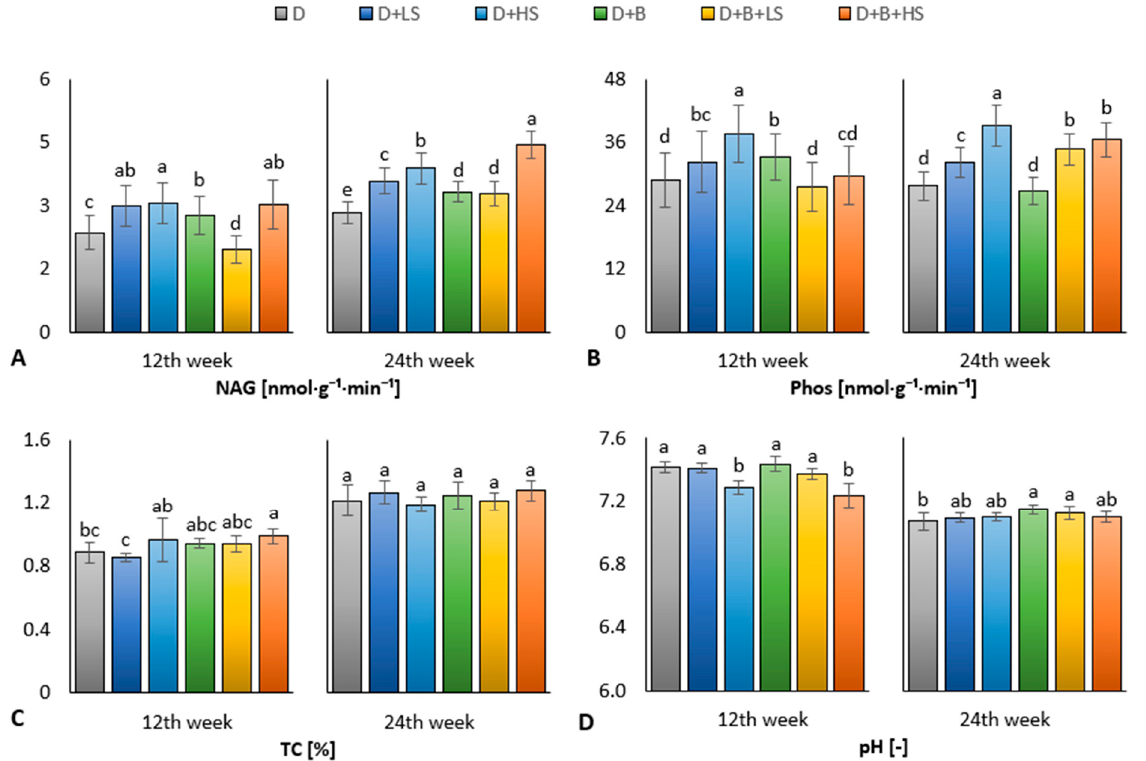
Figure 2. Soil activity of N-acetyl- β -D-glucosaminidase ( A ), phosphatase ( B ), soil total carbon ( C ), and soil pH ( D ) of experimental variants in PreCult (12th week) and MCult (24th week) of maize in the pot experiment. Average values are displayed, and error bars are standard deviation. The different letters of variant values indicate a statistical difference between them at the level p ≤ 0.05.